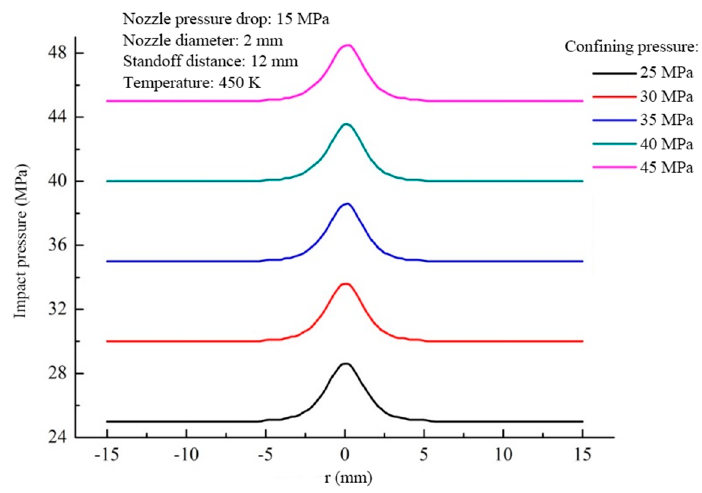
Figure 9. Influence of the confining pressure on impact pressure.